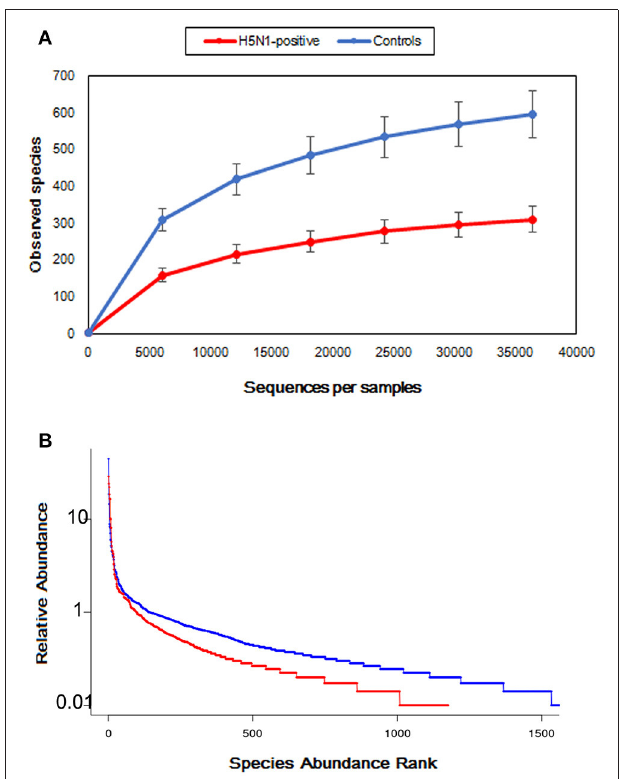
FIGURE 3 | Comparison of the structures of the fecal microbiota of the healthy control, and H5N1-positive groups. (A) Structural comparison of the two groups. The vertical axis shows the number of OTUs that would be expected to be found after sampling the number of tags or sequences shown on the horizontal axis. (B) Rank abundance curve of the bacterial OTUs derived from the two